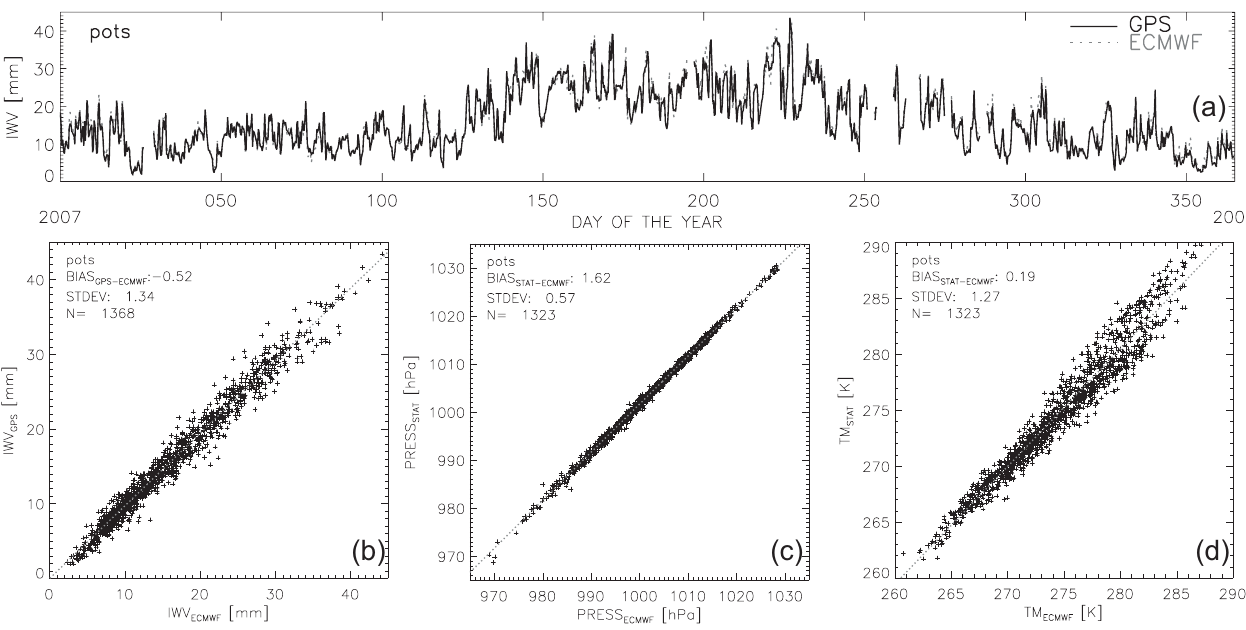
Fig. 1. Results for station Potsdam, year 2007: (a) comparison of IWV from GPS and ECMWF at 00:00, 06:00, 12:00, 18:00UT (time of ECMWF analyses), (b) scatter plot corresponding to (a), (c) comparison of P s from ECMWF and station sensor at 03:00, 09:00, 15:00, 21:00UT (worst case estimation), (d) same as (c) but for T m